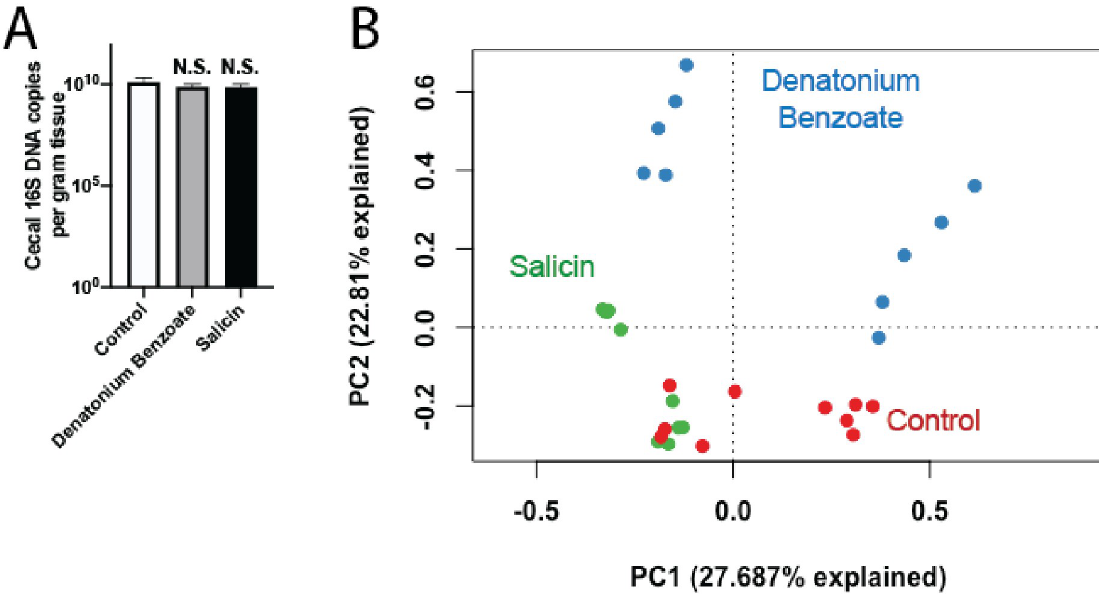
Fig 5. Effects of bitterants on cecal bacteria density and community composition. Mice were treated with antimicrobially-inert but bitter-tasting compounds (3 mM denatonium benzoate or 75 mM salicin) in distilled water, or distilled water alone, for 8 days. Mice were provided ad libitum access to food and water. (A) Comparison of 16S bacterial DNA copy number in mouse cecal tip. n = 10, � P < 0.05. Error bars denote SEM. (B) PCA plot of microbiota in mouse cecum. Each dot represents one mouse. P < 0.0002 for all comparisons